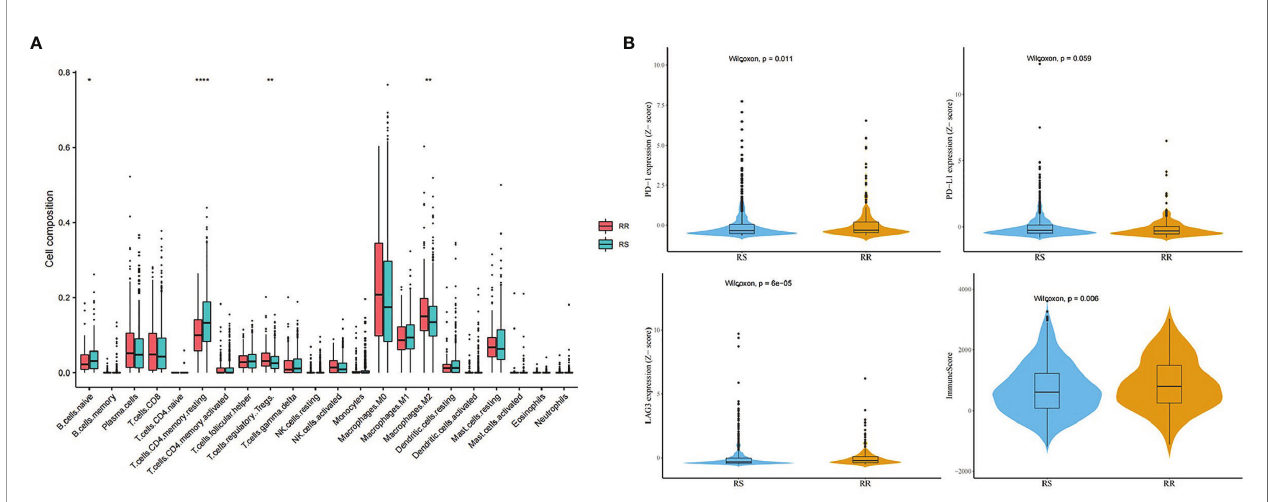
FIGURE 12 | Immune analysis in the whole TCGA BRCA patients. (A) Distribution difference of immune cells between the RS group and the RR group. (B) Comparison of immune checkpoint genes and immune score between the RS group and the RR group (* means P-value <0.05; ** means P-value <0.01; **** means P-value